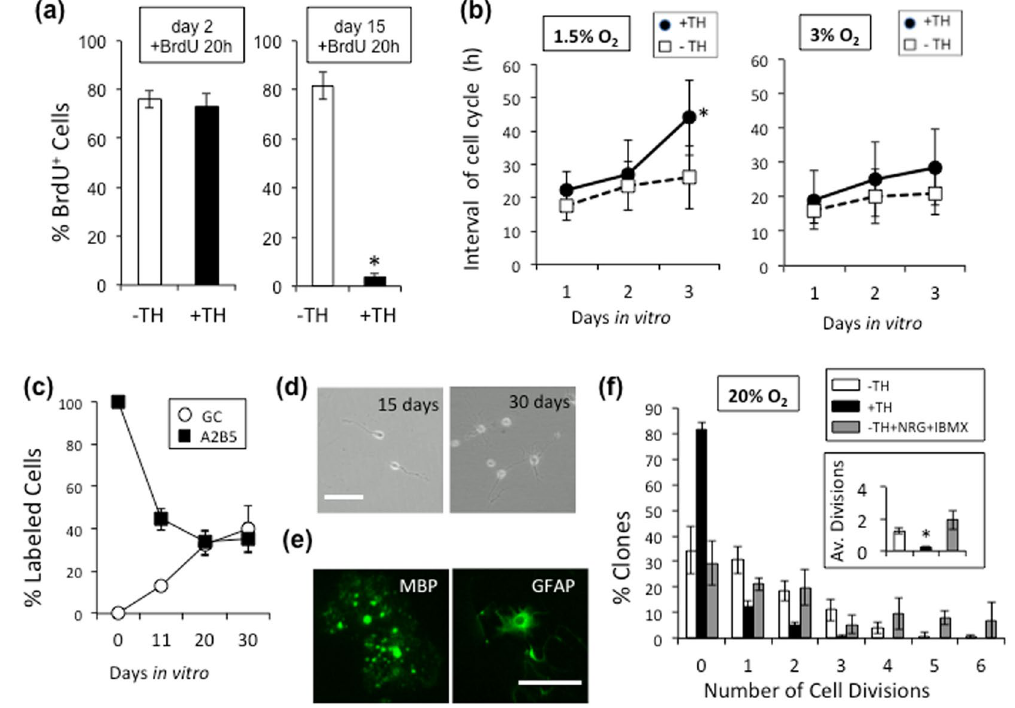
Figure 3. Hypoxia converts perinatal OPCs to adult-like OPCs in culture. ( a ) After 2 or 15 days, with TH ( + TH; black bars ) or without TH (-TH; white bars ), the P7 OPCs cultured in 1.5% O 2 condition were treated with BrdU for 20 hours and then the % of BrdU + cells was determined. * P < 0.001. ( b ) Freshly prepared P7 OPCs were plated in PDGF, with TH ( closed circles ) or without TH ( open squares ) and in either 1.5% or 3% O 2 cultured for 24 hours, after which they were followed by time-lapse video microscopy. The average time between M-phases was estimated on day 1 (0–23.5 hours), day 2 (24–47.5 hours), and day 3 (48–71.5 hours). At the start of image recording, the following number of cells were analyzed: 42 in 1.5% O 2 with TH; 48 in 1.5% O 2 without TH; 131 in 3% O 2 with TH; 89 in 3% O 2 without TH. * P < 0.05. ( c ) After P7 OPCs were cultured at clonal-density for 11, 20 or 30 days in PDGF, TH, and 1.5% O 2 , the cells were labeled with anti-GC and A2B5 monoclonal antibodies and the percent of each type of labeled cells was determined. ( d ) P7 OPCs were cultured in PDGF and TH in 1.5% O 2 for 15 or 30 days, and representative fields were examined by phase-contrast microscopy. Scale bar: 50 μ m. ( e ) P7 OPCs cultured for 15 days as in ( d ) were then either deprived of PDGF for 5 days and labeled for MBP or treated with 10% FBS for 5 days and labeled for GFAP. Scale bar: 100 μ m. ( f ) P7 OPCs cultured in PDGF and TH in 1.5% O 2 for 15 days were removed and re-cultured at clonal-density for another 7 days in PDGF in 20% O 2 — without TH ( white bars ), with TH ( black bars ), or without TH in the presence of NRG1 (50 ng/ml) and IBMX (100 μ M) ( gray bars ). The average numbers of cell divisions are show in the inset (1.24 ± 0.18 without TH; 0.24 ± 0.60 with TH; 1.95 ± 0.60 without TH, but with NRG1 and IMBX). * P <